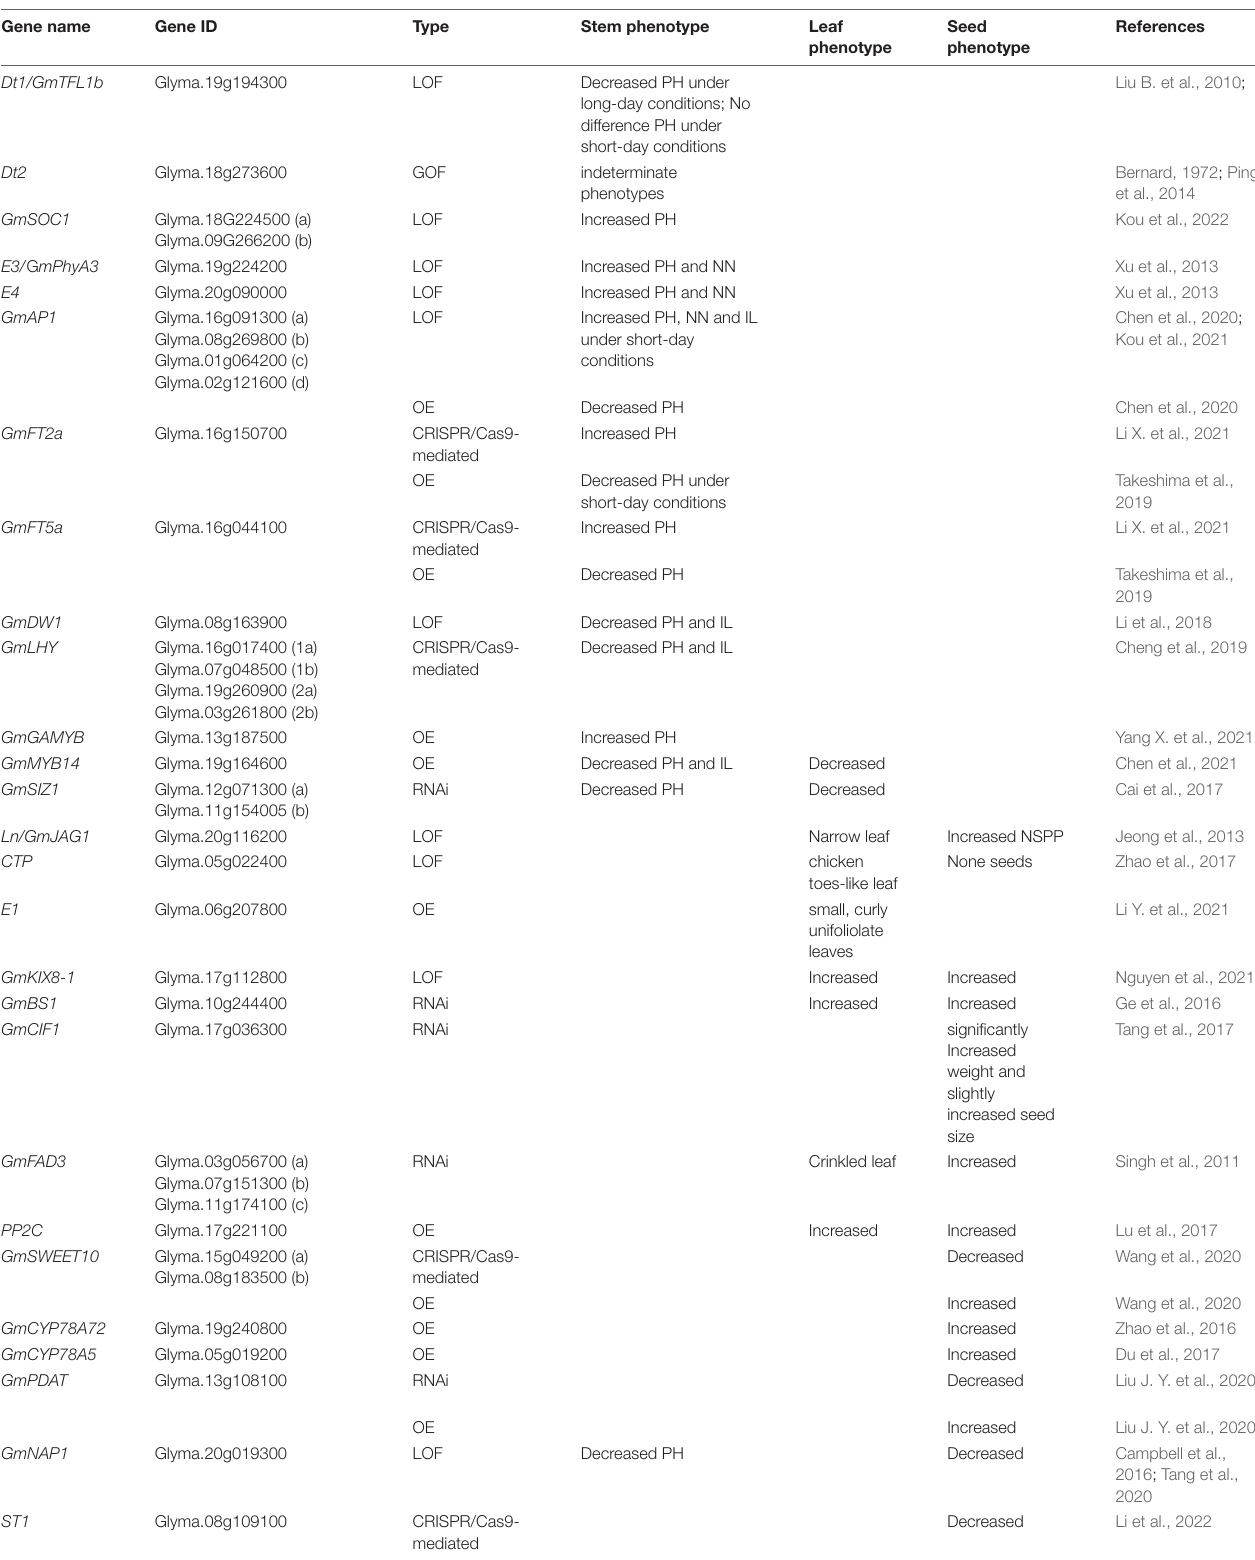
TABLE 1 | Published function genes regulating the organ size and shape of